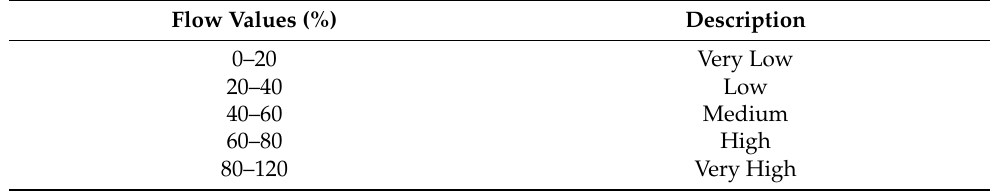
Table 4 . Workability of foam concrete based on flow [74] . Table 4. Workability of foam concrete based on flow [74].